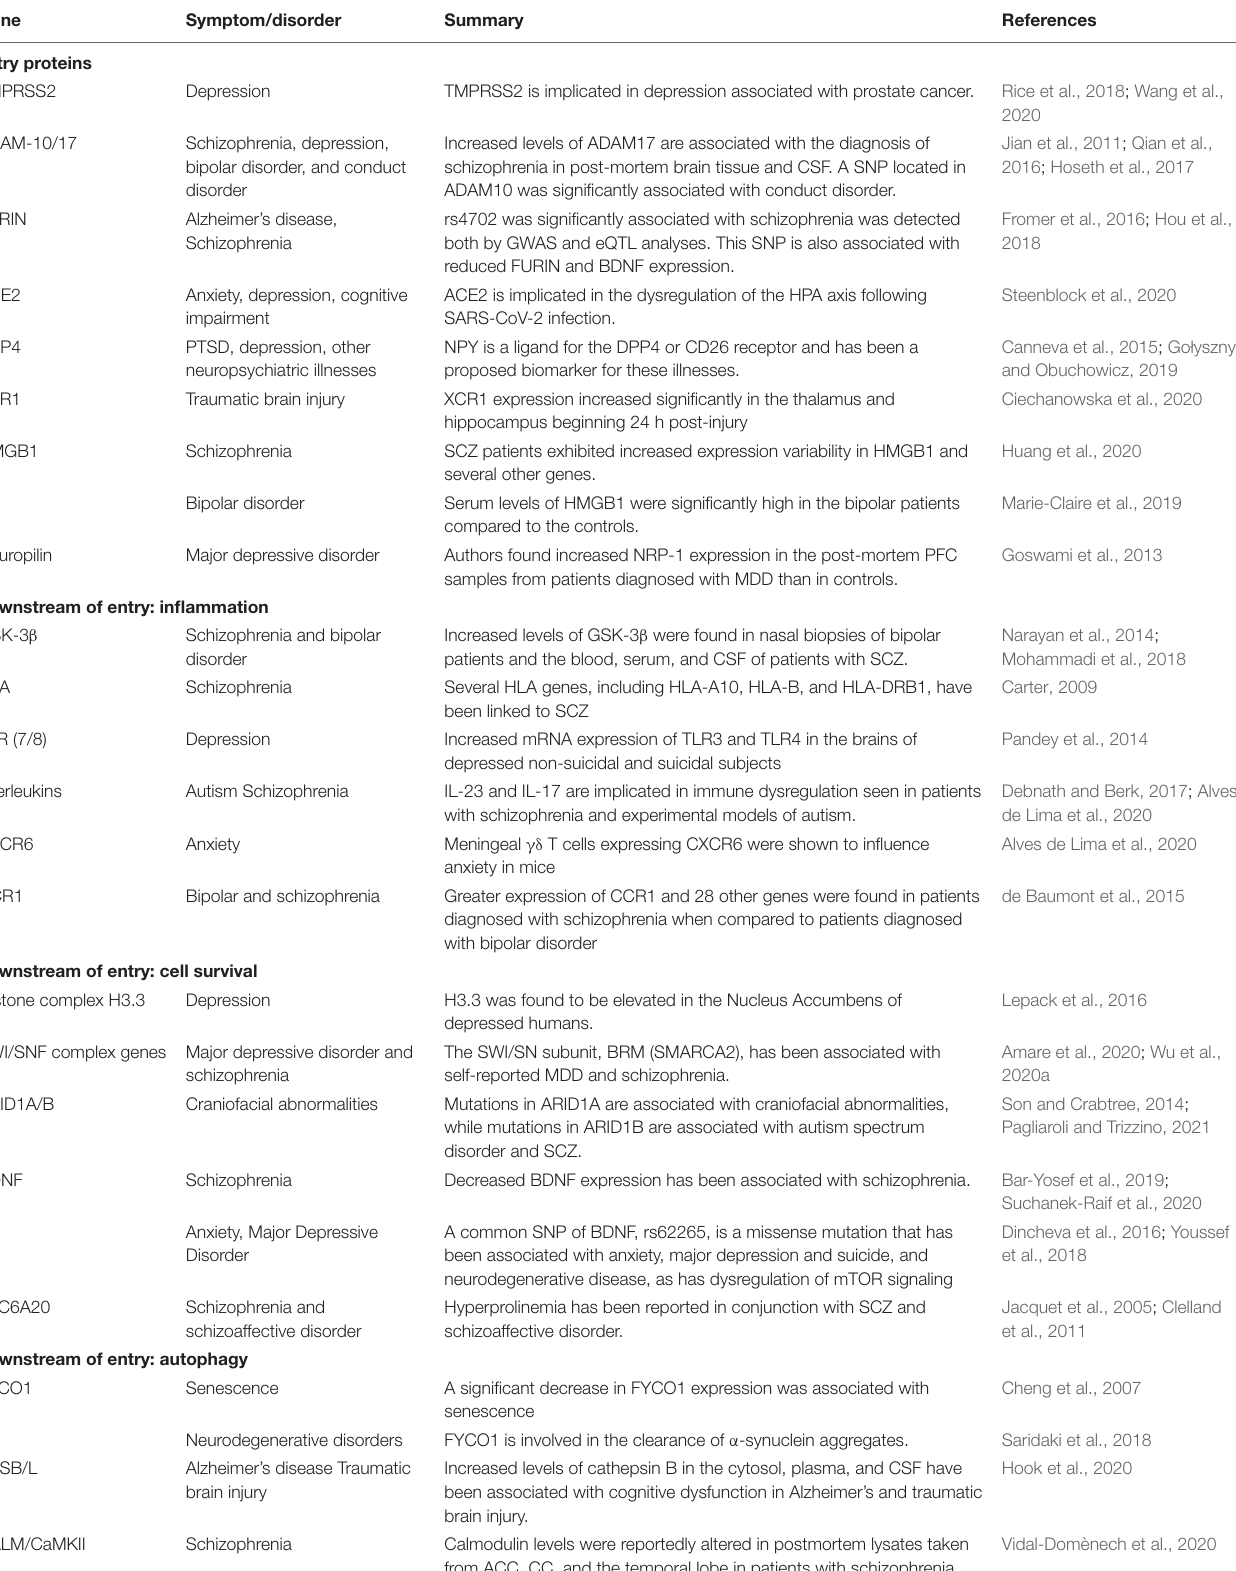
TABLE 1 | Host genes involved in SARS-CoV-2 infection and mental